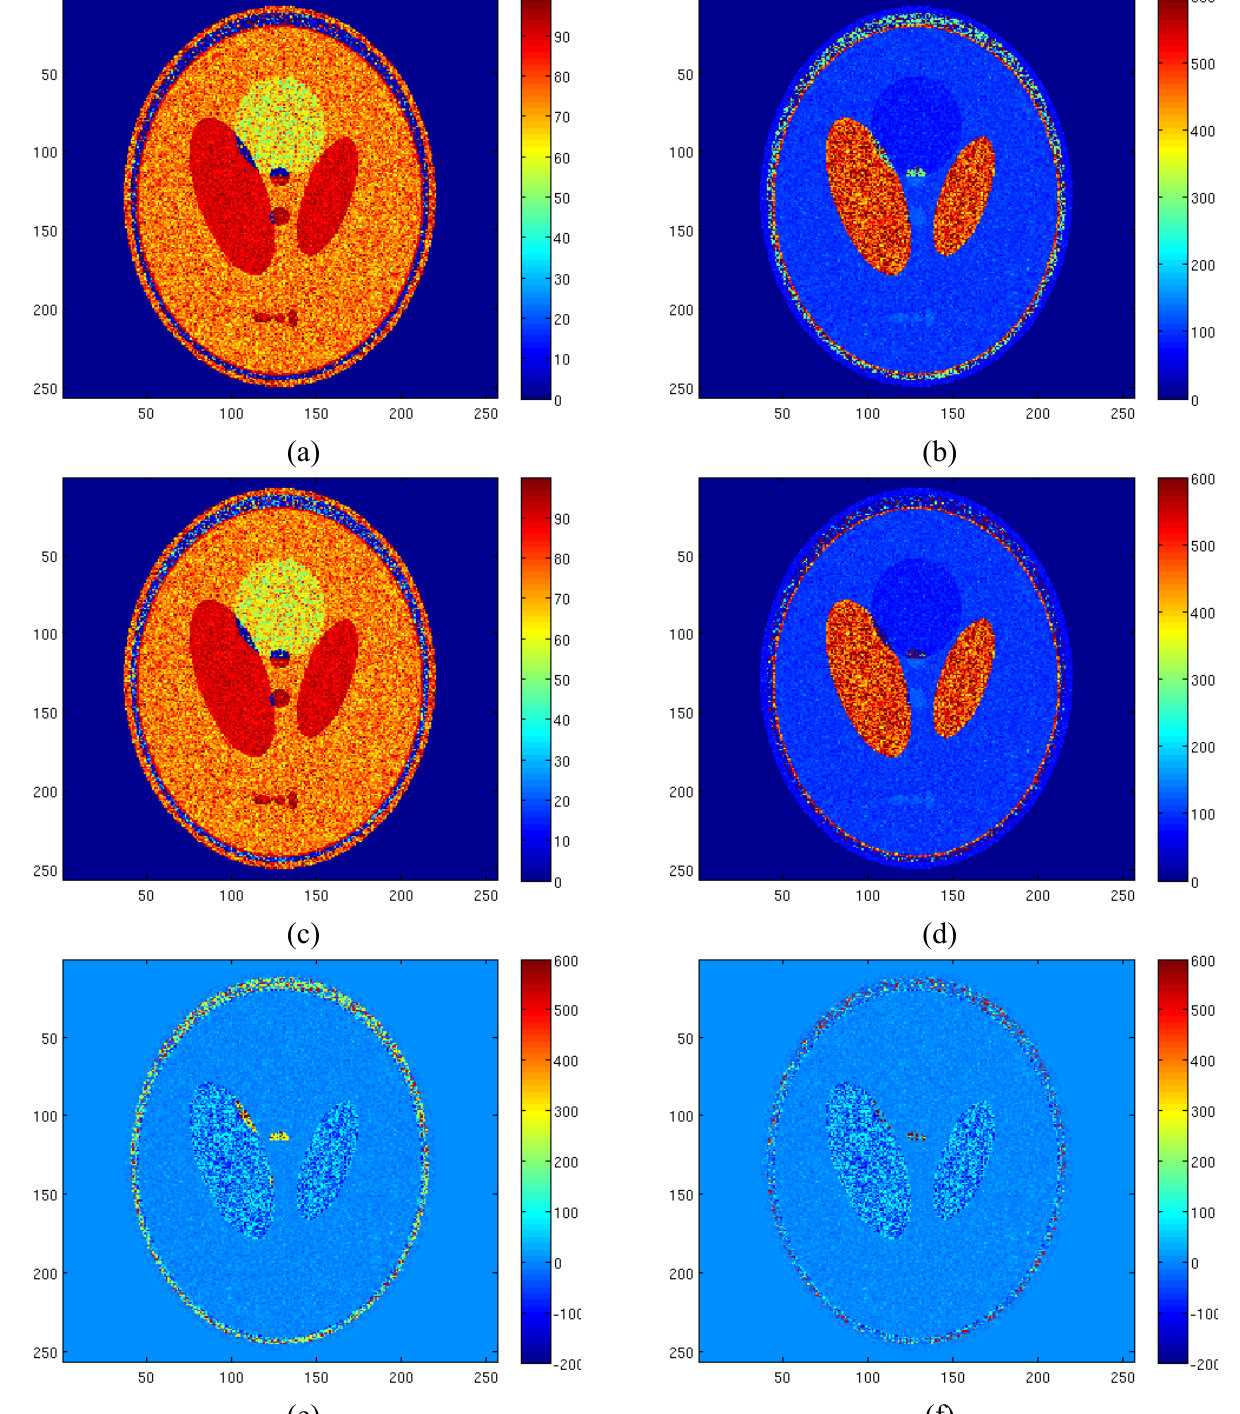
Figure 8. Estimated pseudodensity map using ML estimator with Rician amplitude map using ML estimator with Rician amplitude model (b), model (a), estimated T 2 estimated pseudodensity map using LS estimator with Gaussian complex model (c), map using LS estimator with Gaussian complex model (d), T estimated T 2 error map using ML estimator with Rician amplitude model (Normalized mean square reconstruction error map using LS estimator with Gaussian error equal to 0.1546) (e), T 2 complex model (Normalized mean square error equal to 0.1029)